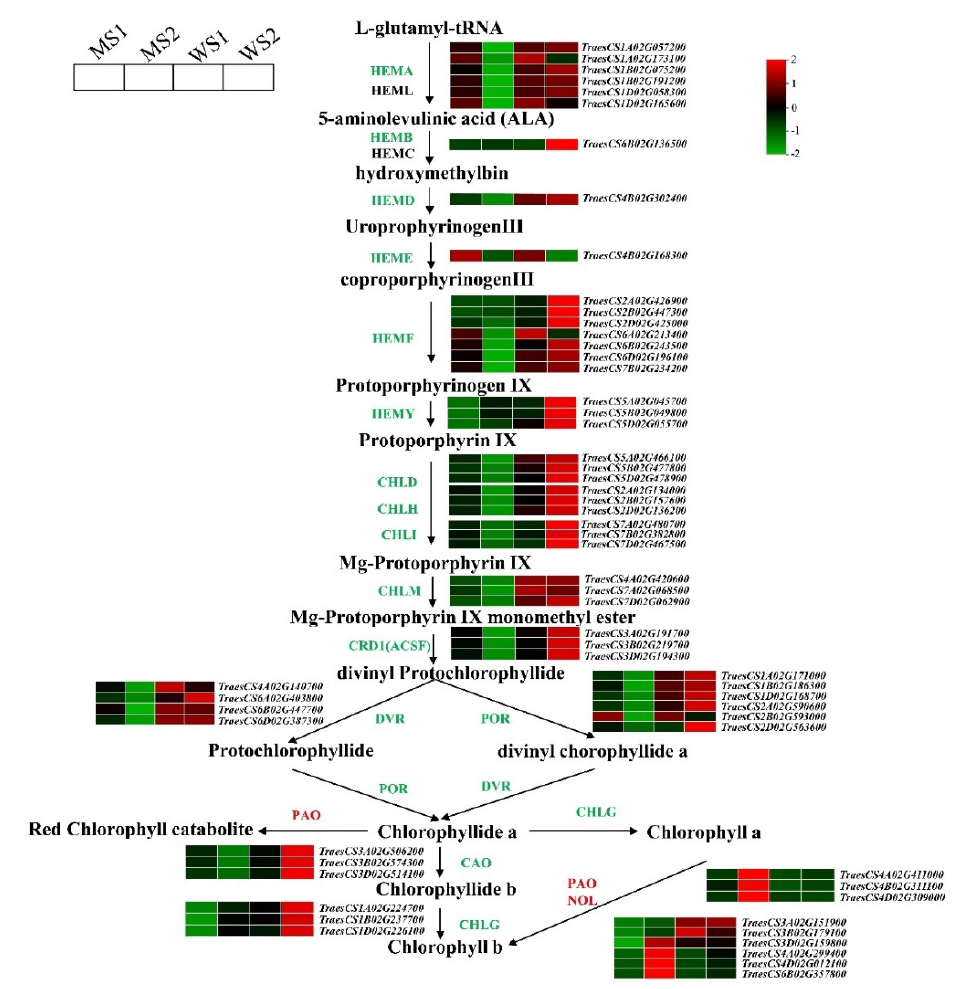
Figure 5. chlorophyll metabolic pathway. Genes are shown in different colors. Relative gene expression levels are indicated by a color gradient from low (green) to high (red). Squares are arranged from left to right: MS1 (early senescence stage of mutant), MS2 (late senescence stage of mutant), WS1 (early senescence stage of wild-type), and WS2 (late senescence stage of wild-type). Numbers in the scale bar represent normalized transcripts per kilobase million (TPM) values of genes.